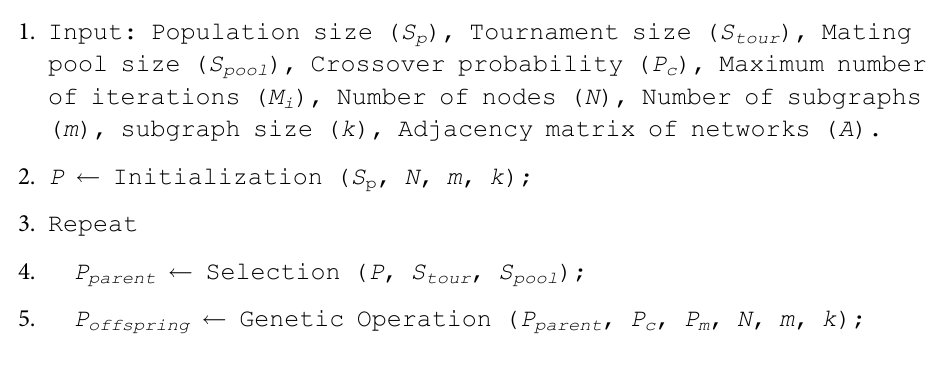
Algorithm 1. Framework of MA-M m C k